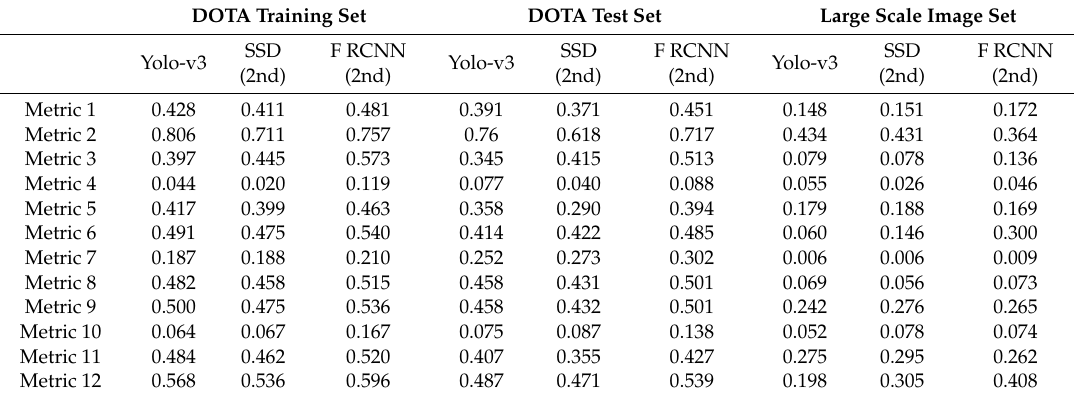
Table 4. Performance of DOTA training, DOTA test, and large-scale image set according to COCO metrics. DOTA Training Set DOTA Test Set Large Scale Image